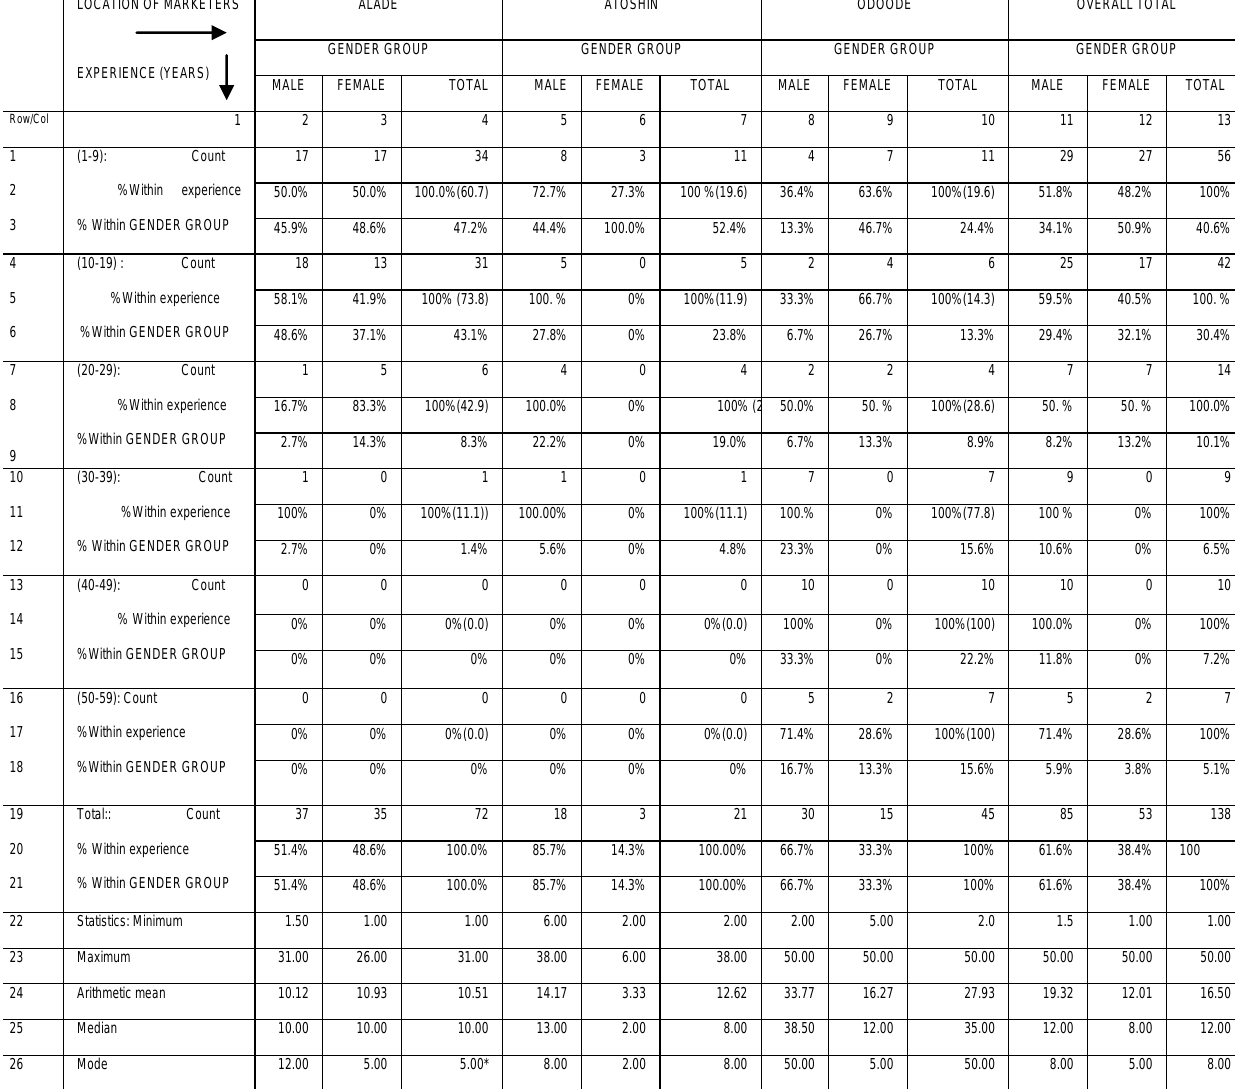
Table 2: Distribution and statistic of respondents’ year in business as cocoa marketers by gender and location Ondo State of Nigeria 2000/2001season . ALADE ATOSHIN ODOODE OVERALL TOTAL GENDER GROUP GENDER GROUP GENDER GROUP GENDER GROUP